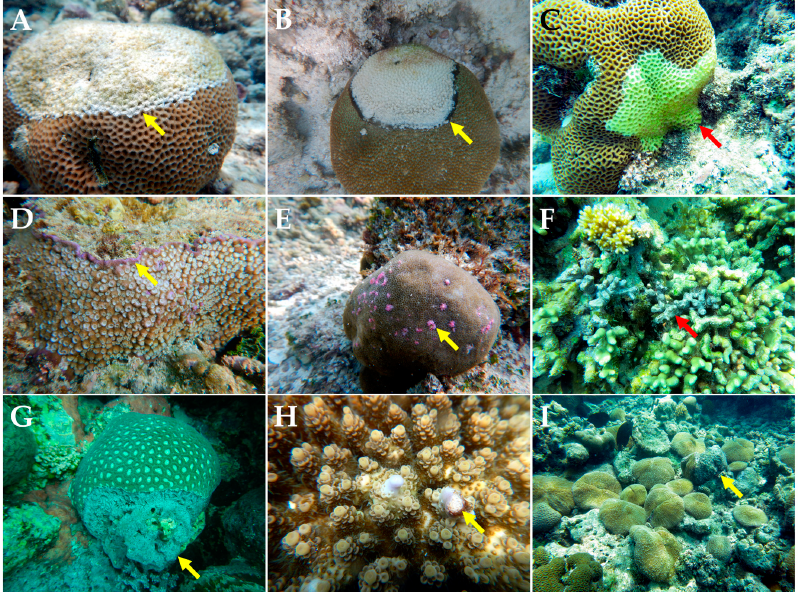
Figure 2. Bangaram and Thinnakara (BT Atoll): ( A ) White syndrome in G. edwarsi (yellow arrow); ( B ) Black band disease in Hydnophora sp. (yellow arrow); ( C ) Tissue loss in G. edwarsi (red arrow); ( D ) PLS in A. ocellata (yellow arrow); ( E ) Trematodiasis/PS in P. solida (yellow arrow); ( F ) BD/ T . hoshinota and CHS on P. cylindrica (yellow arrow) [21]; ( G ) BD/ T . hoshinota overgrowing D. lizardensis (yellow arrow) [21]; ( H ) Gas in Acropora sp. (yellow arrow); ( I ) CHS (yellow arrow) in Fungiidae [Photos by R.R.Das, C.R.Sreeraj, G.Mohan].